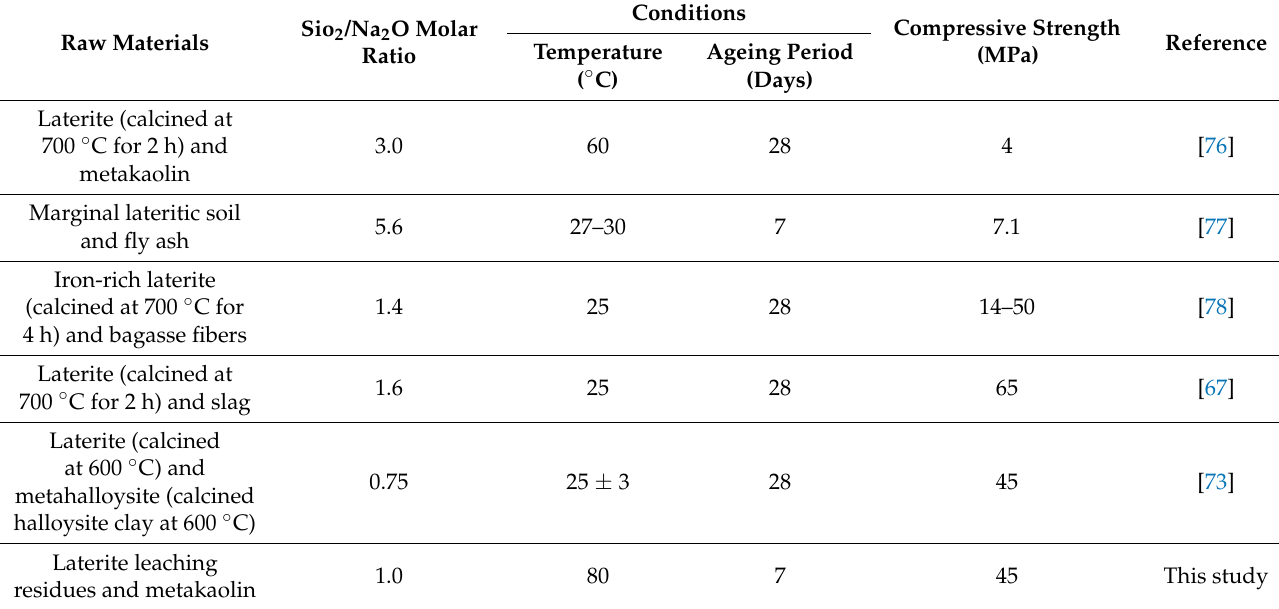
Table 6. Comparison of results of various studies using laterite-based